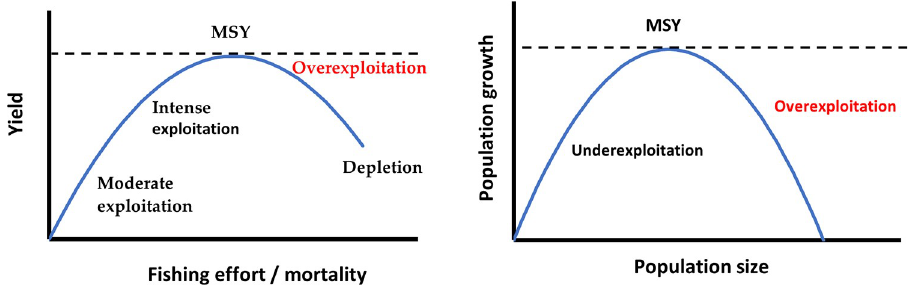
Fig 2. The MSY point. Own elaboration based on Seijo et al. [20].